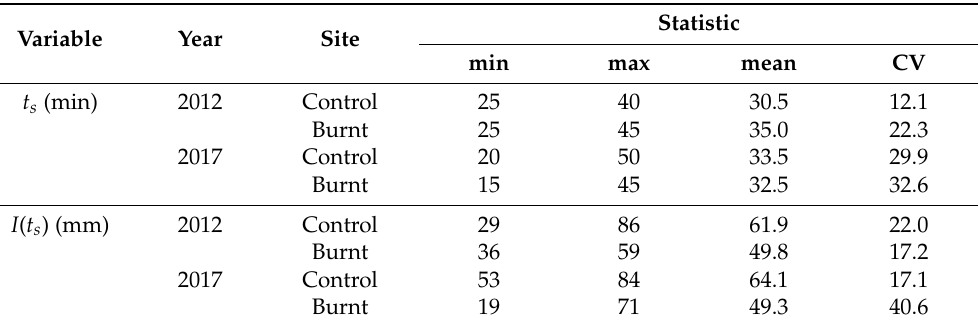
Table 3. Summary of the equilibration time, t s (min), and infiltrated depth at the equilibration time, I ( t s ) (mm). Sample size, N = 10 for each site and sampling campaign.